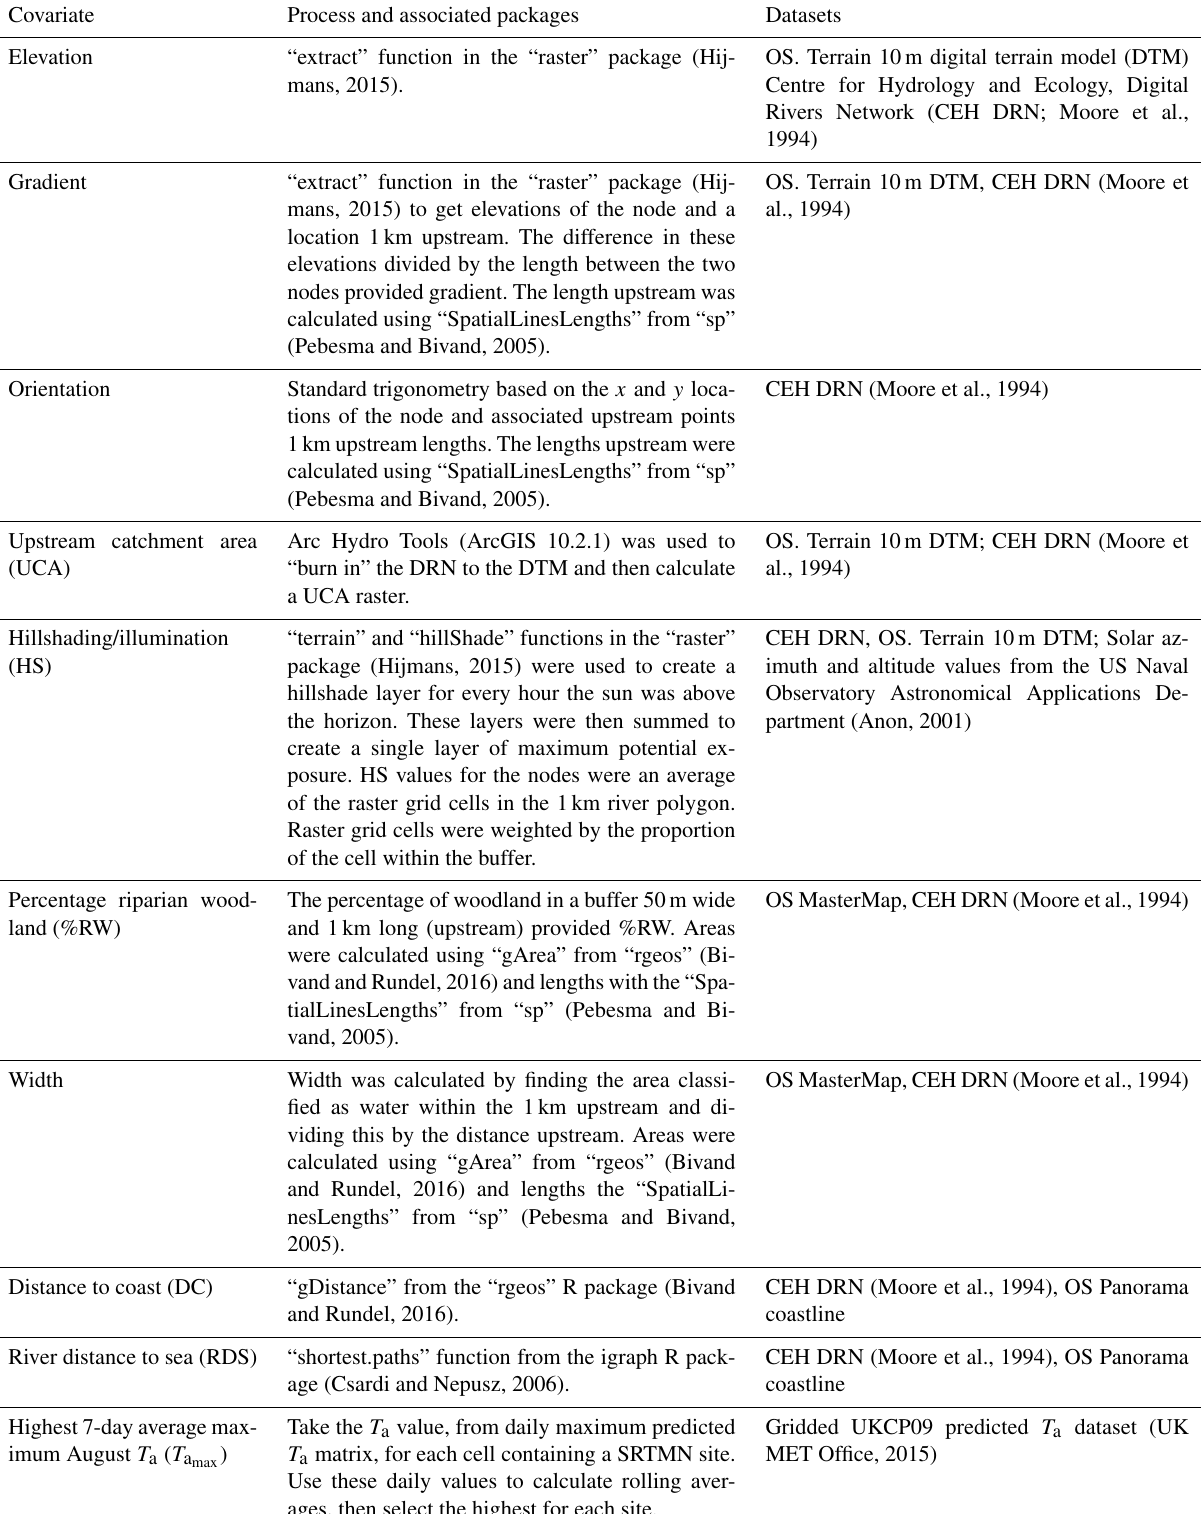
Table 1. Covariate calculations. All calculations were in R version 3.2.3 (R Core Team, 2015) except where